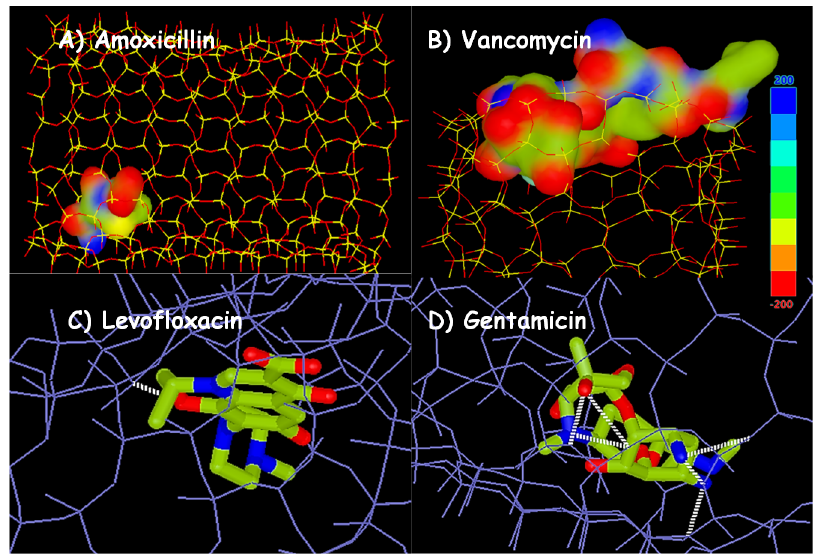
Figure 4. Molecular 3D models carried out with Hex 8.0 software. Electrostatic potential density maps for ( A ) amoxicillin and ( B ) vancomycin forced to penetrate into a 3.0 × 4.0 nm silica mesopore. Molecular modelling interactions studies where pure silica matrix model was used as receptor and ( C ) levofloxacin and ( D ) gentamicin as ligands.